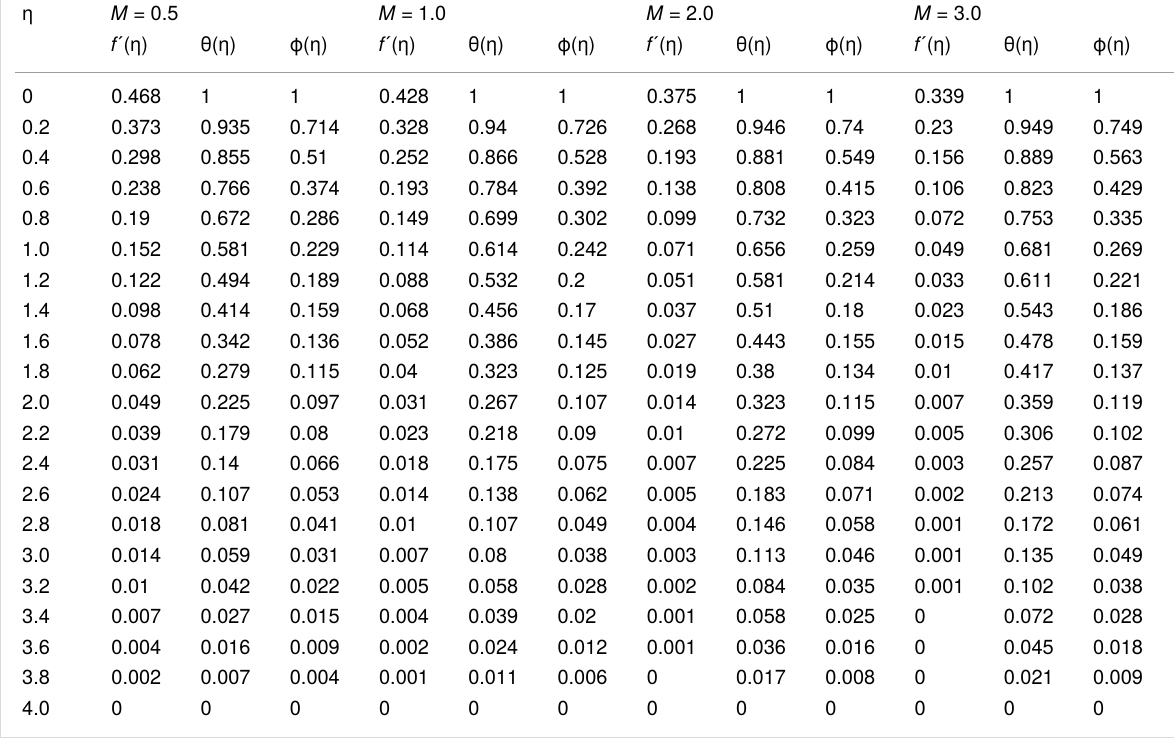
Table 2: Computation of the streamwise velocity, temperature and concentration profiles for different values of the magnetic field parameter, M . η M = 0.5